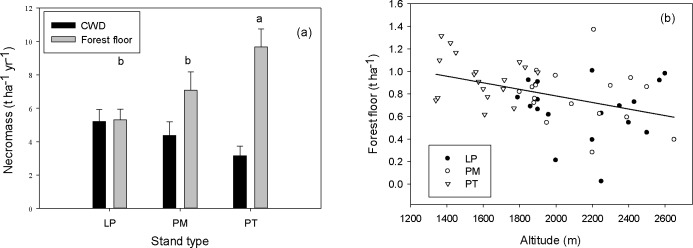
CWD and forest floor necromass (a) and forest floor necromass (after natural-log transformation) along the altitudinal gradient (b) in three coniferous forests on the Loess Plateau, China. LP, Larix principis-rupprechtii forest; PM, Picea meyerii forest; PT, Pinus tabulaeformis forest. Different letters in (a) indicate significant differences of the forest floor necromass (p<0.05) among three forest types. Solid line in (b) represents a significant linear relationship (r2 = 0.16, p = 0.003) between altitude and forest floor necromass across the three forests.